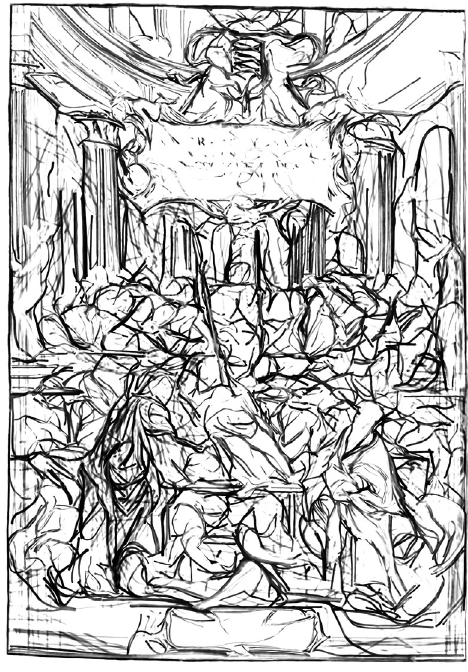
Fig. 3 - Illustration of Andreas Vesalius’s work in an amphitheater (Adapted [11]